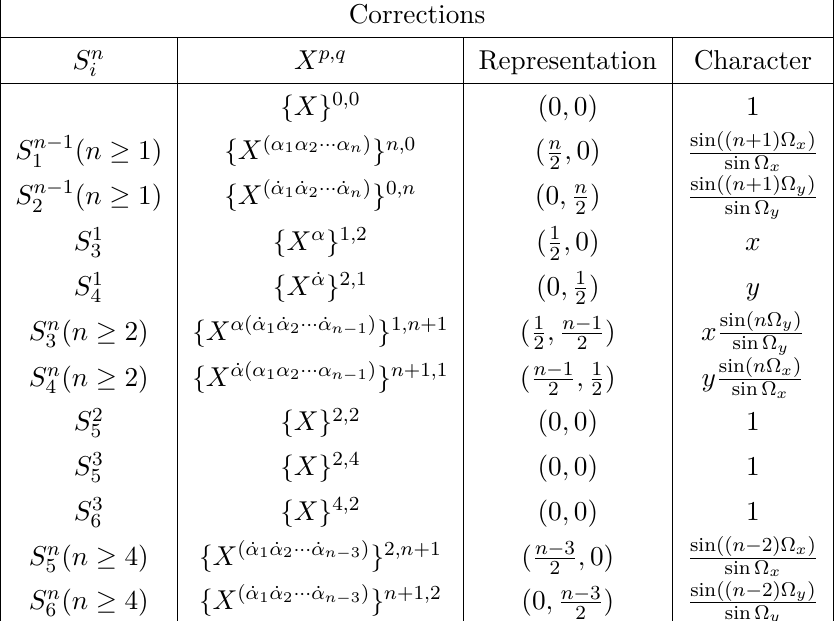
Table 1. This table summarizes the representation of each space and the corresponding character. The translation from X notation to S notation is also provided. Here, x and y are defined as x = α + 1 and y = β + 1 , where α, β are the SU(2) L , SU(2) R group parameters, and Ω x,y are α β defined by x, y ≡ 2 cos(Ω x,y )